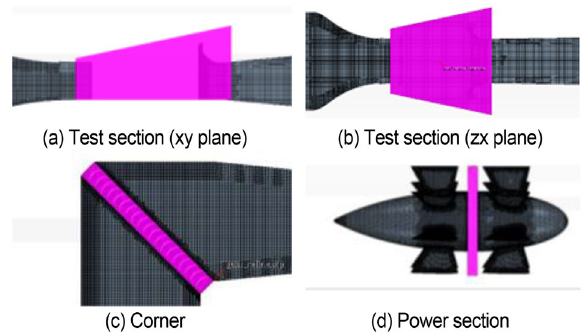
Figure 6. The dense areas of volume mesh.